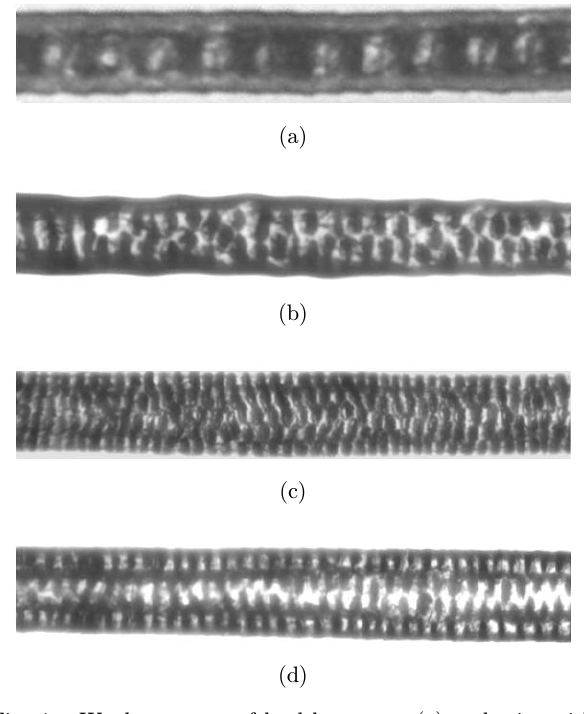
Fig. 1. Wool structure of healthy mouse (a) and mice with cancertumor1 cm(b),2 cm(c)and3 cm(d).Magni¯cationx400.